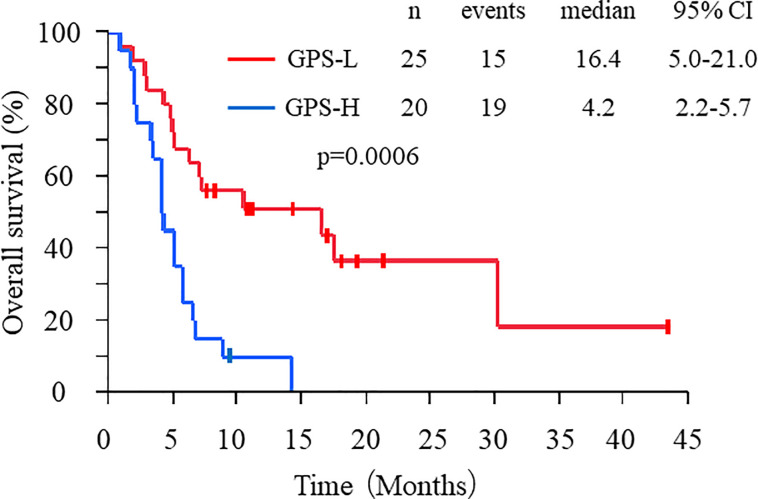
OS of patients sorted by GPS.Kaplan–Meier analysis of OS in GPS-L (red line) and GPS-H (blue line) patients.